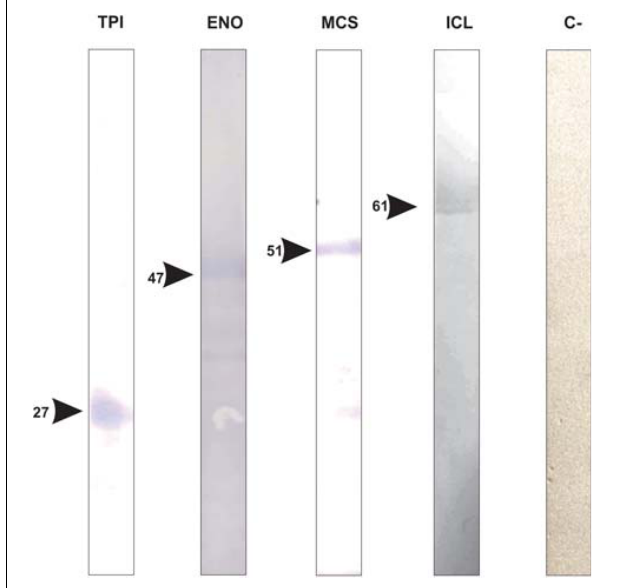
FIGURE 3 | Validation of GAPDH interacting proteins by co-immunoprecipitation assay. The figure shows the confirmation of GAPDH being complexed with proteins that we found as a result of chromatographic and co-immunoprecipitation assays TPI (triose phosphate isomerase), ENO (enolase), MCS (2-methylcitrate synthase), ICL (isocitrate lyase) and C-(negative